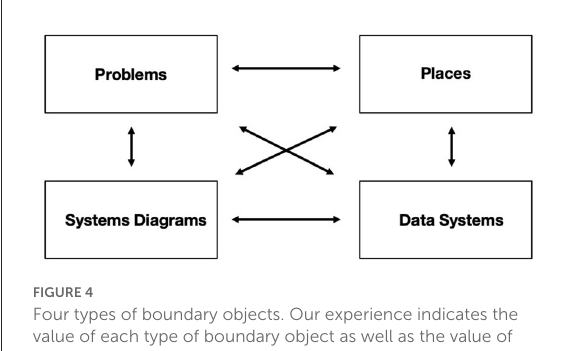
FIGURE4 Four types of boundary objects. Our experience indicates the value of each type of boundary object as well as the value of using them together as an interacting